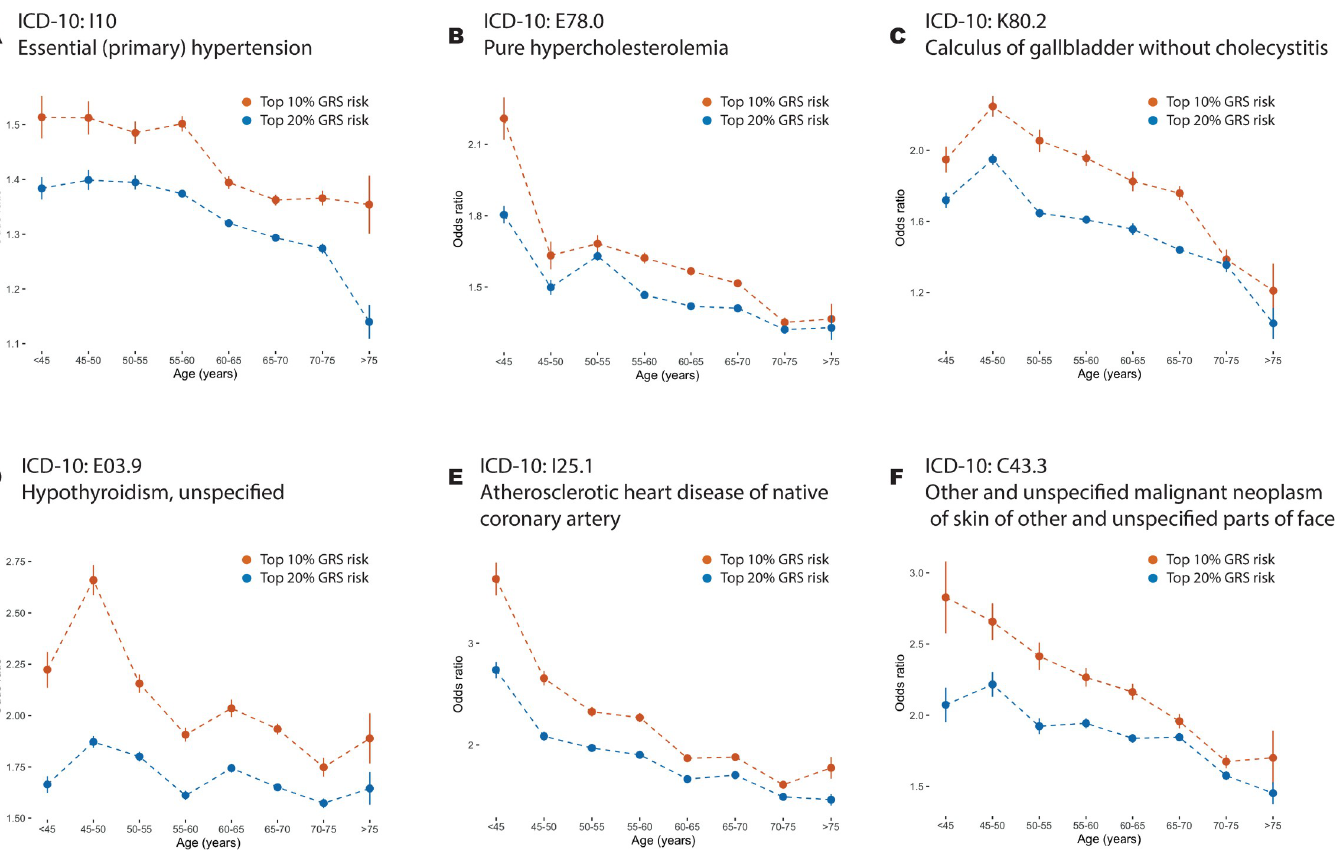
Fig 2. Age-stratified odds-ratios for combined genetic risk scores. (A-F) Age-stratified odds ratios in held-out testing data for genetic risk scores for six disorders where there is evidence for a single non-constant genetic risk profile, “Primary (essential) hypertension” (ICD-10 code I10), “pure hypercholesterolaemia” (E78.0); “Calculus of gallbladder without cholecystitis” (K80.2) and “Hypothyroidism, unspecified” (E03.9); “atherosclerotic heart disease of native coronary artery” (I25.1) and “other and unspecified malignant neoplasm of skin and unspecified parts of face” (C44.3). Results for all diseases are shown in S1 Fig. Odds ratios for the 80th (blue) and 90th percentiles of a combined genetic risk score within matched case-control samples (four controls for each case) are shown for each age interval; points indicate the average odds ratio of twenty five-fold cross-validation analyses with lines indicating the 95% confidence interval.